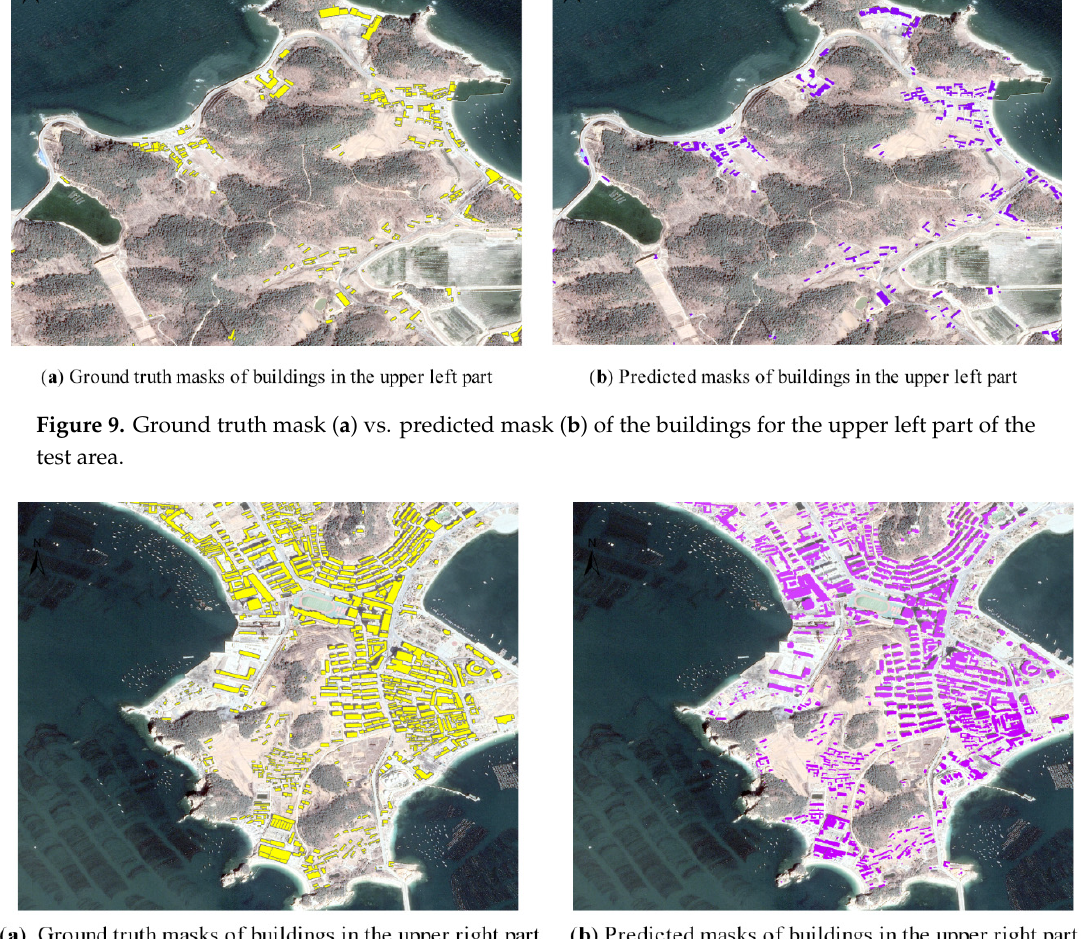
Figure 10. Ground truth mask ( a ) vs. predicted mask ( b ) of the buildings for the upper right part of the test area.